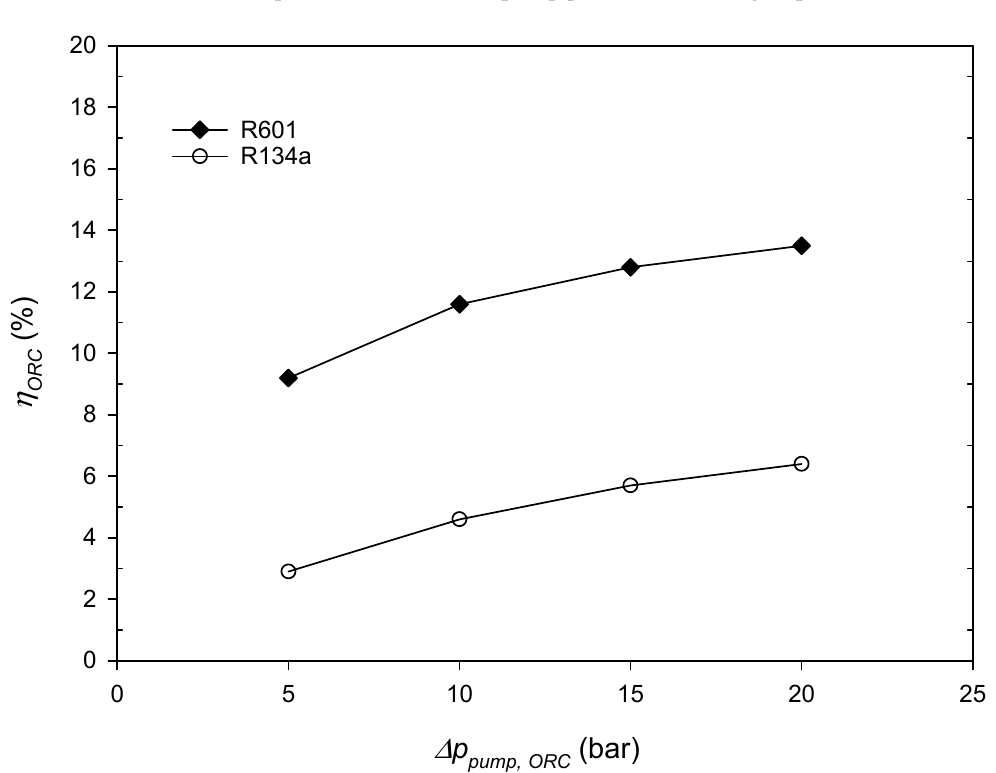
Figure 9. ORC power as a function of pump pressure increase, grid point 6.